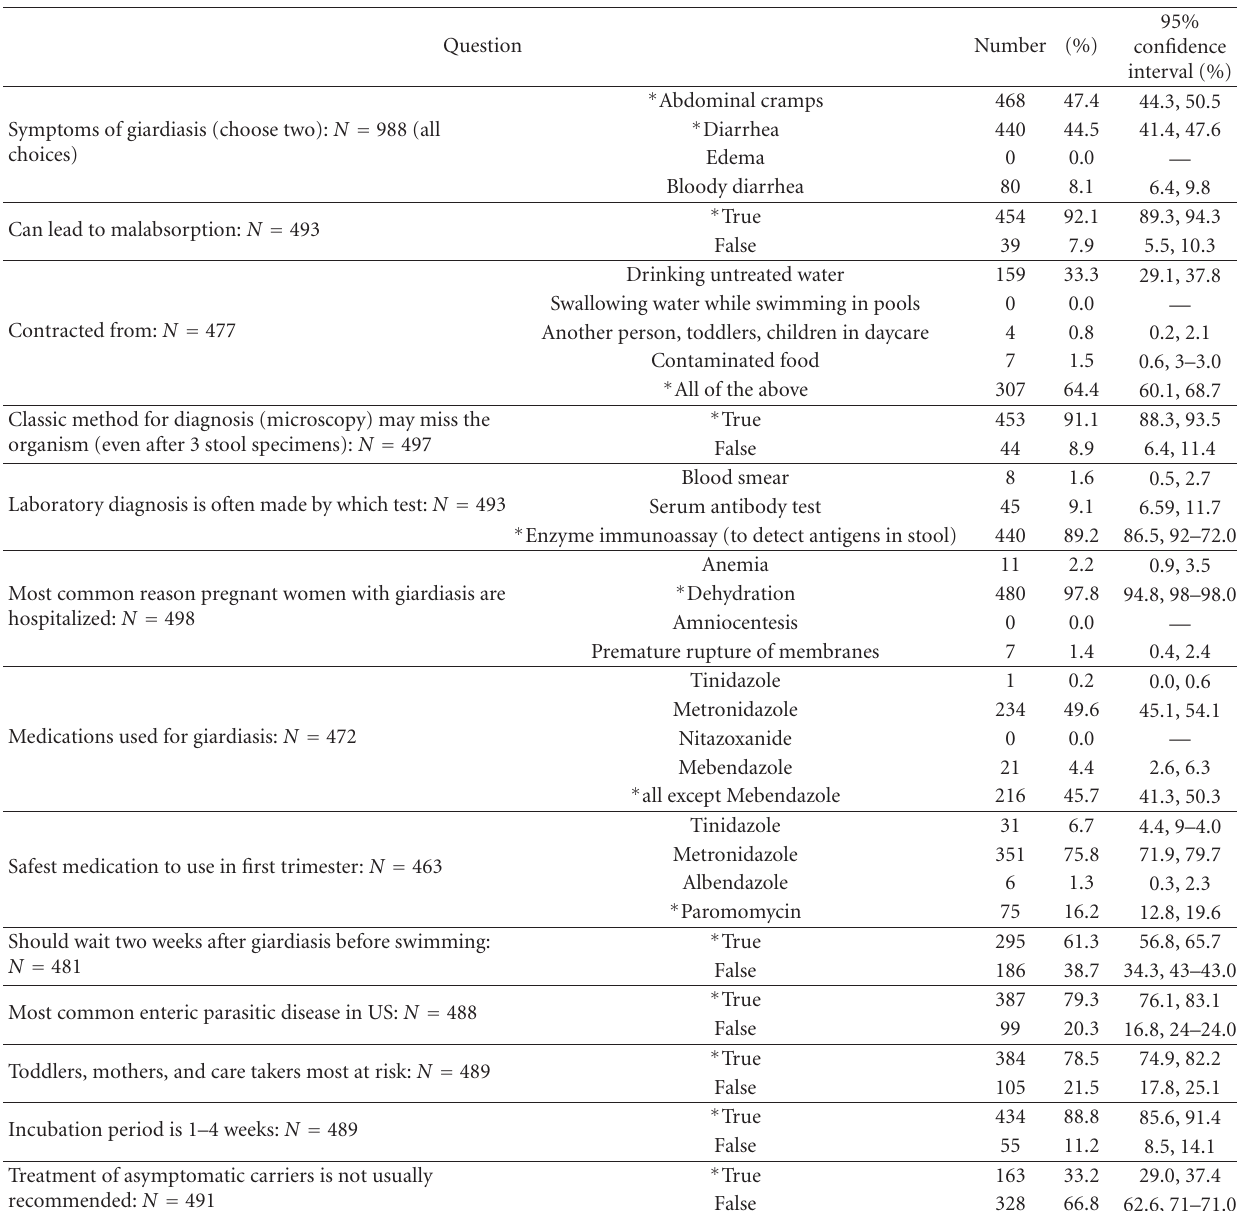
Table 2: Frequencies and confidence intervals for giardiasis survey questions, sample of obstetrician-gynecologists in the American College of Obstetricians and Gynecologists,